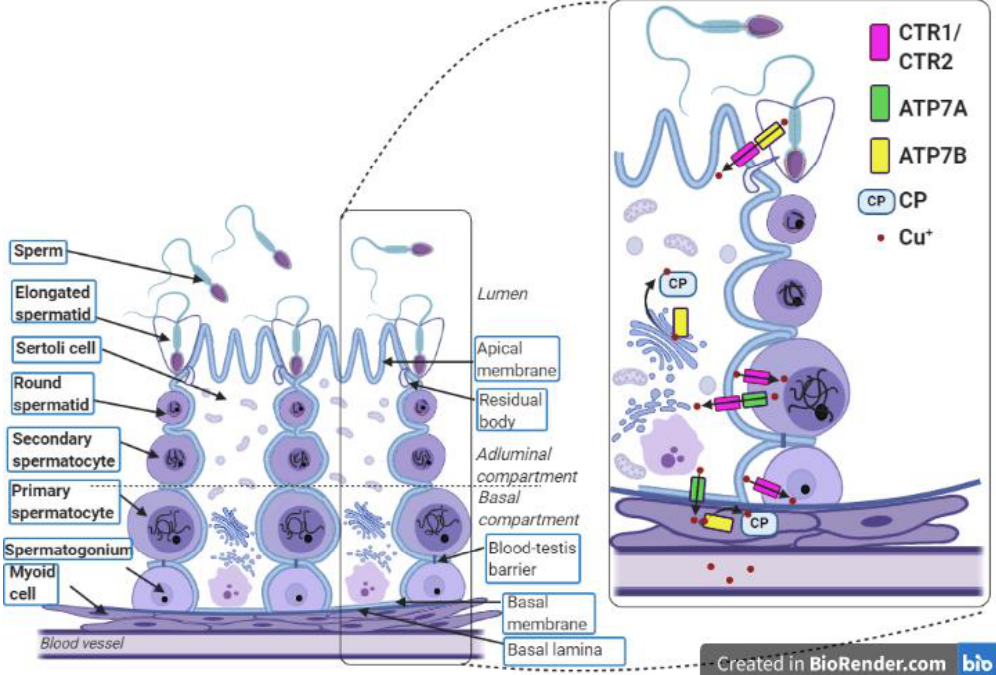
Figure 2. Localization of copper-related proteins in the seminiferous tubule and myoid cells. In the testes, gametes are produced during the multi-step process called spermatogenesis, which covers a complex network of regulations that occur in the seminiferous tubules. Each seminiferous tubule is surrounded by a few layers of myoid cells that border on blood vessels. The seminiferous epithelium contains the Sertoli cells and the germ cells and lies on the basal lamina. The lumen of the seminiferous tubule is filled with seminal fluid. The Sertoli cells are polarized cells that reach the lumen of the seminiferous tubule and support the individual stages of developing germ cells. Sertoli cells are linked by tight junctions that form a blood–testis barrier. This divides the seminiferous epithelium into the adluminal and basal compartments and allows Sertoli cells to control the environment for developing late germ cells. The first stages of the germ cell line are spermatogonia, which lie on the basal lamina. Above them, primary and secondary spermatocytes are successively situated. The next stages are round spermatids, which transform into elongated spermatids. After absorption of residual bodies, Sertoli cells release the elongated spermatids into the seminiferous tubule lumen where these spermatids become sperm. The transport of Cu ions during the process of spermatogenesis occurs between germ cells, Sertoli cells, and myoid cells. Spermatogonia, primary spermatocytes, and Sertoli cells absorb copper using CTR1. The excess copper is exported from the primary spermatocytes and Sertoli cells through the ATP7A protein. Presumably, a similar function is performed by ATP7B in the elongated spermatids. Removed Cu + ions are imported to Sertoli cells through CTR1. In Sertoli cells and myoid cells, copper is delivered to the ceruloplasmin via ATP7B. In the complex with ceruloplasmin, Cu + ions leave the myoid cells and enter the bloodstream. This figure was created with BioRender.com.